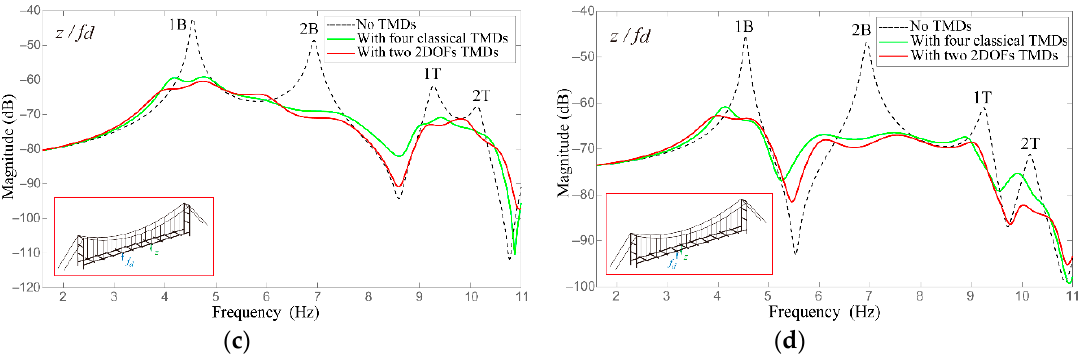
Figure 4. Numerical results: FRFs of the deck respect to different measuring position ( a – d ). The excitation point is fixed.